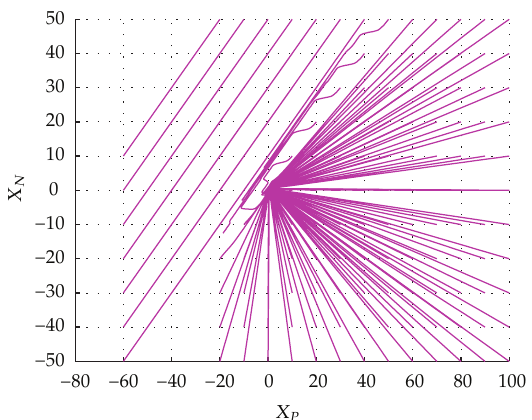
Figure 1: Coexistence of divergent and local stable solutions of (2) with almost periodic